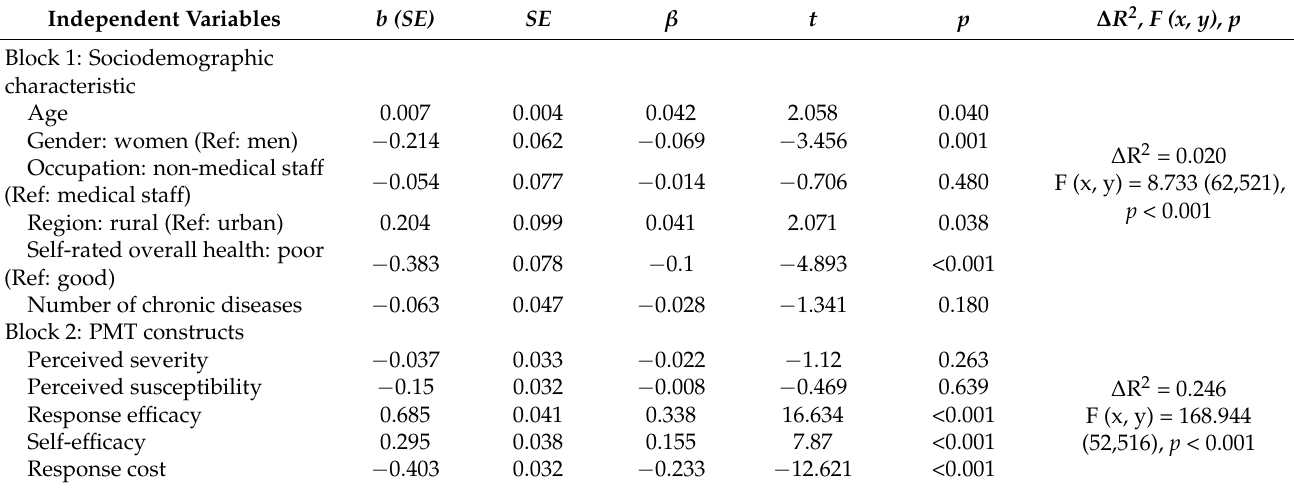
Table 3. Hierarchical regression model testing of PMT in COVID-19 vaccination